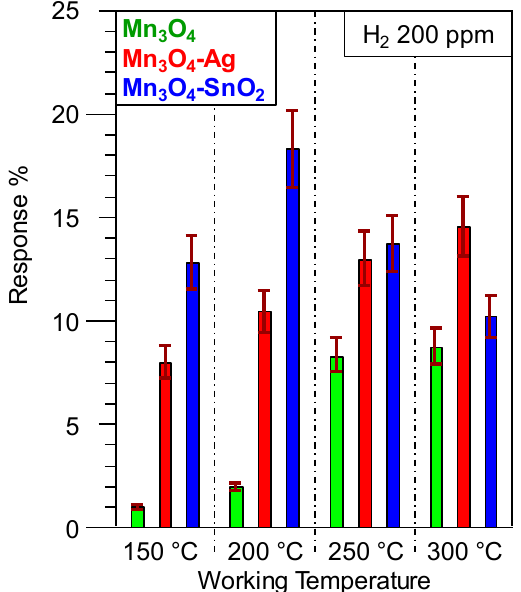
Figure 8. Gas responses to a fixed H 2 concentration (200 ppm) for the target Mn 3 O 4 -based sensors at different working temperatures.